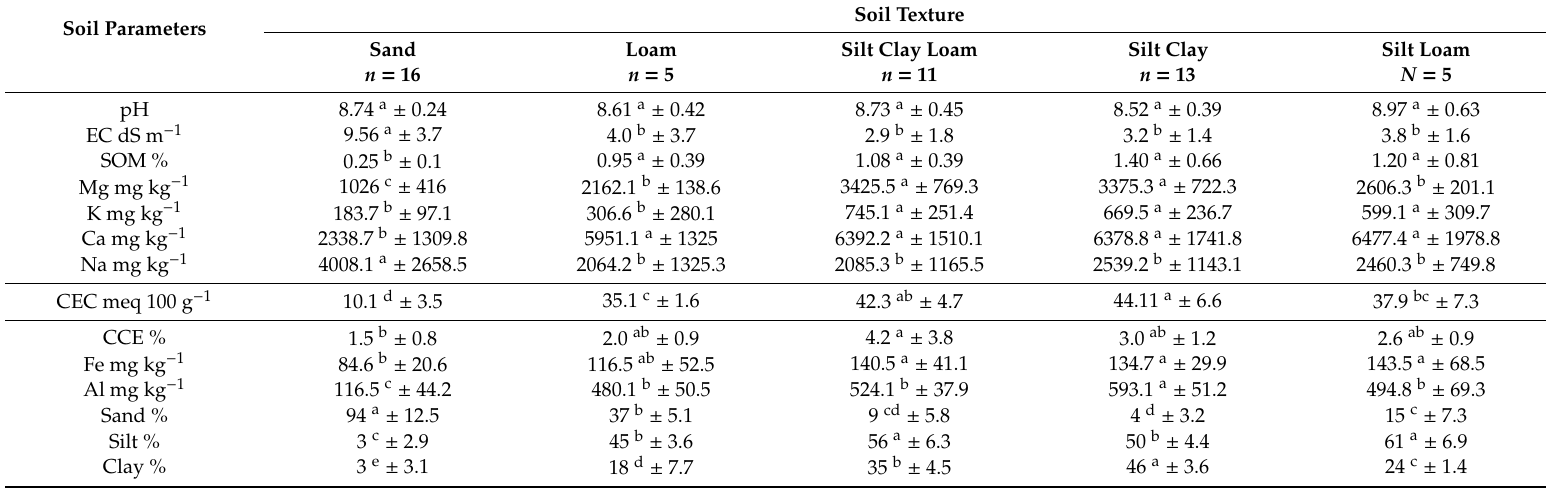
Table 1. The mean and standard deviation values of selected physiochemical soil properties in the di ff erent soil textures investigated. Soil